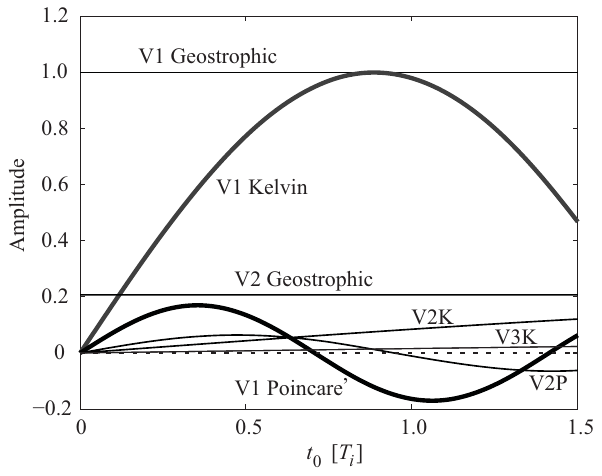
Fig. 3. Several modal velocity amplitudes as functions of forcing time t 0 . All values are normalized by the maximum value of the amplitude of the Kelvin wave of vertical mode-one. Amplitudes of geostrophic waves (effective during wind event only) are included as